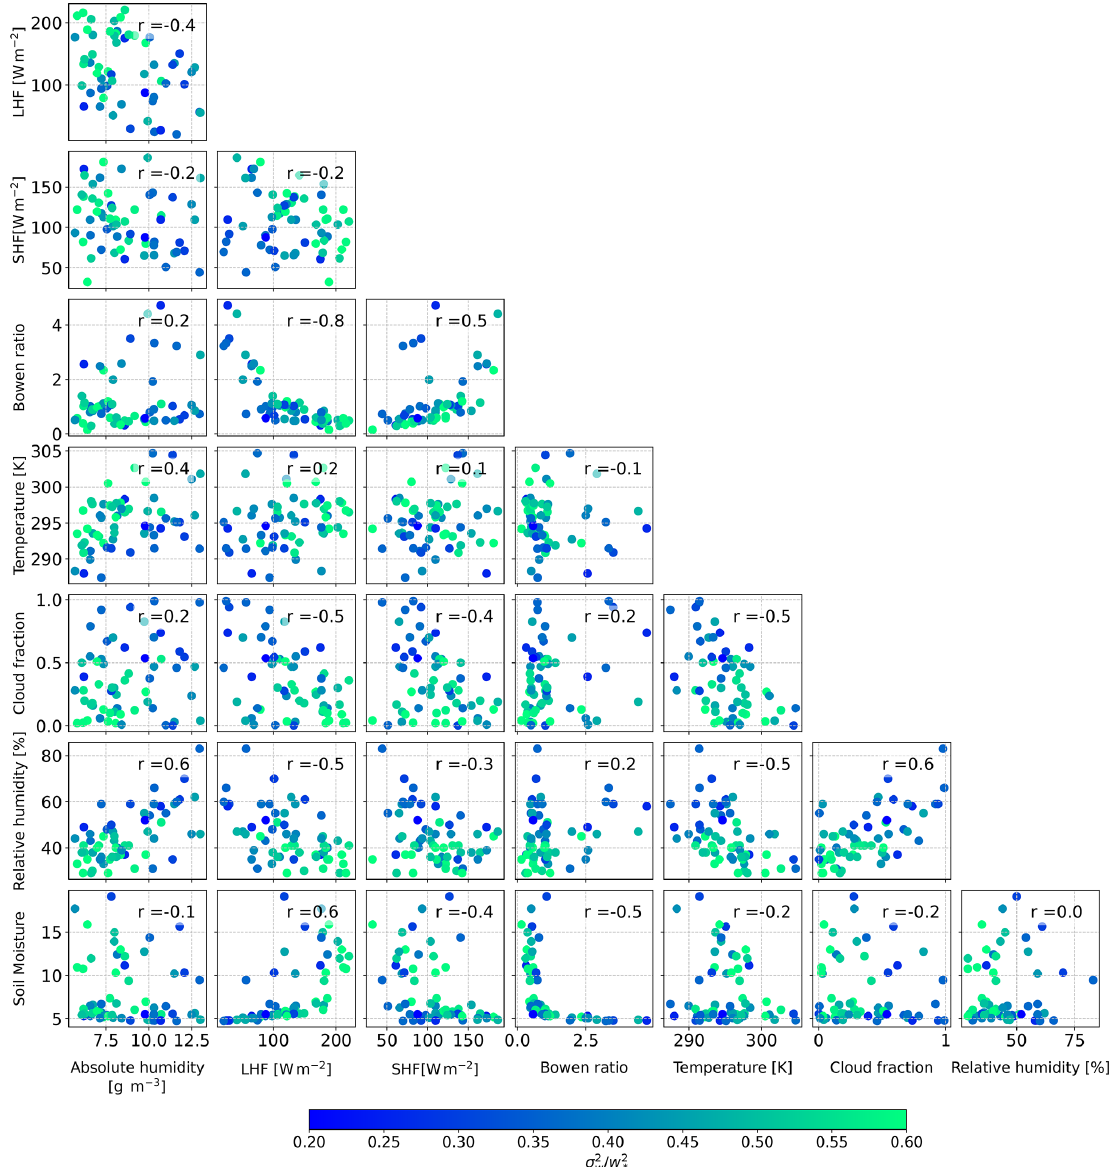
Figure 14. Correlation matrix of seven meteorological parameters, with colour representing the maximum value of the daily average of σ 2 w /w 2 ∗ below 0.6 z i